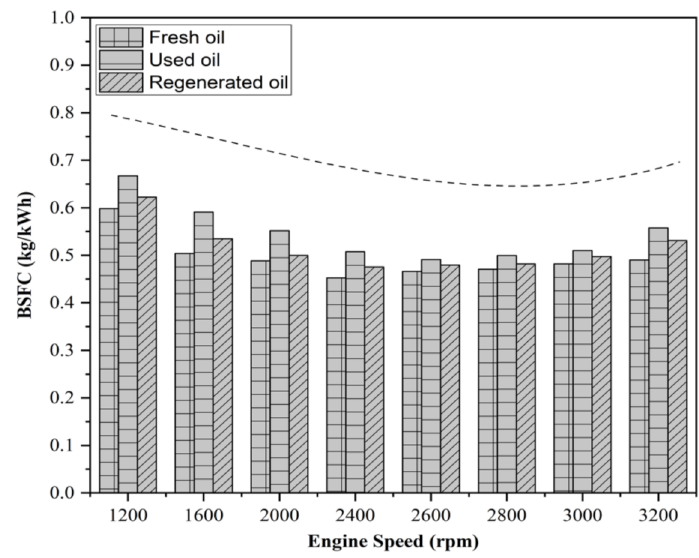
Figure 6. BSFC variation with